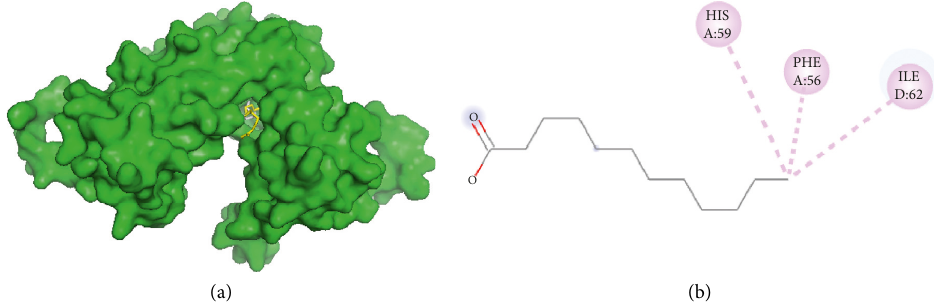
Figure 3: Interaction of lauric and palmitic acids with filaggrin. (a) 3D visualization: lauric acid (yellow) and palmitic acid (grey). (b) 2D visualization: amino acid residues in lauric acid and palmitic